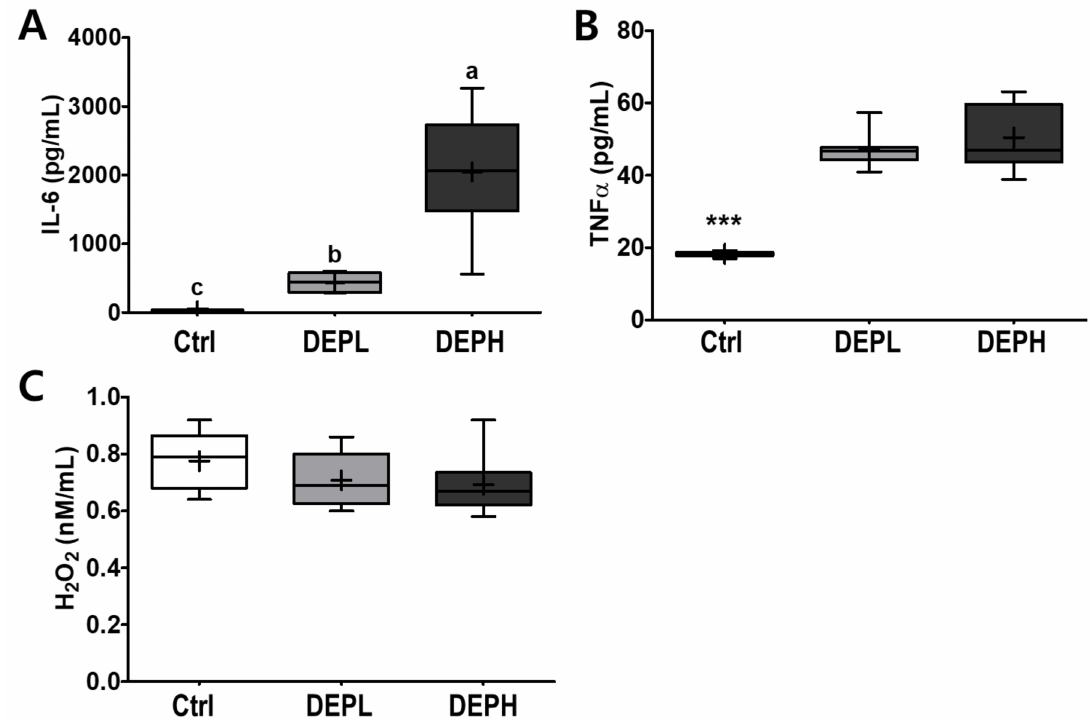
Figure 5. Box-and-whisker plots showing interleukin 6 (IL-6), tumor necrosis factor-alpha (TNF α ), and hydrogen peroxide (H 2 O 2 ) levels in broncho-alveolar lavage fluid (BALF) after repeated exposures to diesel exhaust particles (DEP) for 7 consecutive days: ( A ) IL-6, ( B ) TNF α , and ( C ) H 2 O 2 ; n = 8 for each group. A one-way ANOVA followed by Tukey’s post-hoc test was performed; labeled means without a common letter differ ( p < 0.05); *** p <